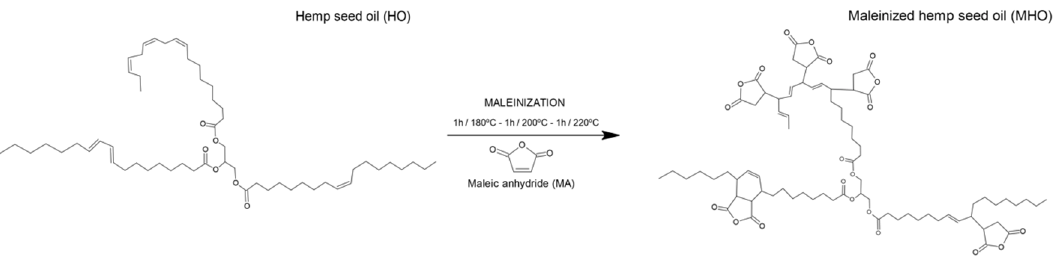
Figure 1. Schematic representation of the obtention of maleinized hemp seed oil (MHO).